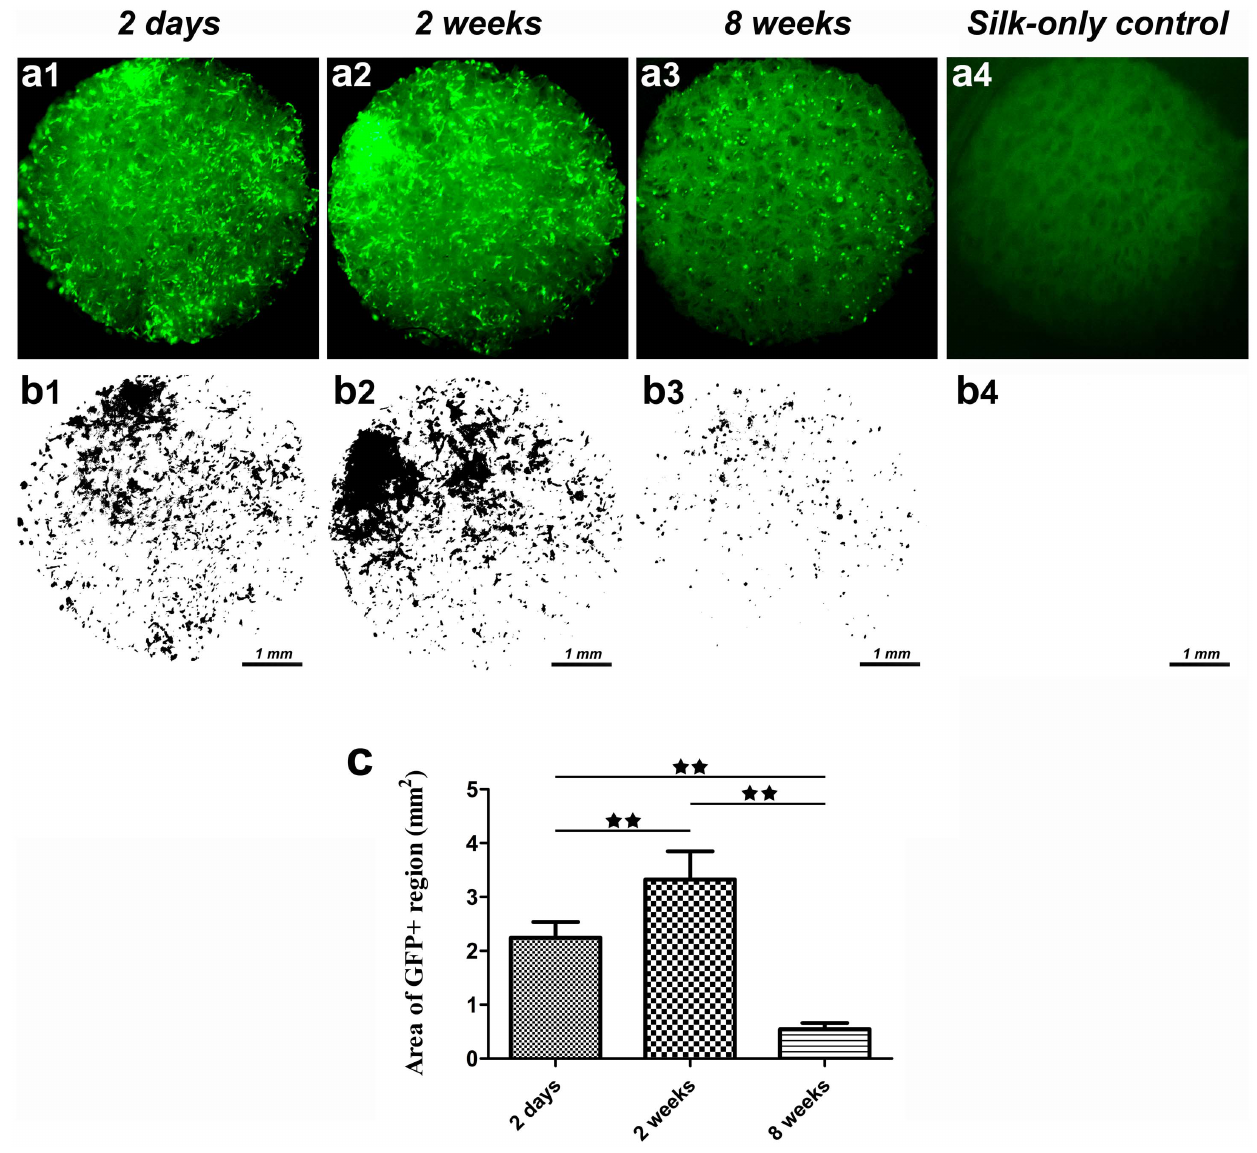
Figure 3. The fate of rat BMSCs cultured with silk scaffolds invitro . (a) Sequential observation of GFP labelled cells in the scaffolds by fluorescence microscopy. (b) Black-white images processed using Image J software. (c) The graph shows the area of GFP positive regions for the different study groups. ( ww , represents p , 0.01). doi:10.1371/journal.pone.0102371.g003 bone area in group S + V/B and group S + V/B + cells were 13.35 6 1.85 mm 2 and 17.23 6 1.04 mm 2 , respectively. There was a significant difference between the two groups ( p , 0.01) (Figure 6b). In addition, the comparison between group Silk (5.13 6 1.15 mm 2 ) and group S + cells (7.06 6 1.17 mm 2 ) showed a statistically significant difference ( p , 0.05). However, the gap between the Silk group and the S + cells group was less than that between the S + V/B group and S + V/B + cells group. We conclude from the results that the growth factors play an important role in promoting bone formation from stem cells. vascularization were sacrificed with an overdose of pentobarbital